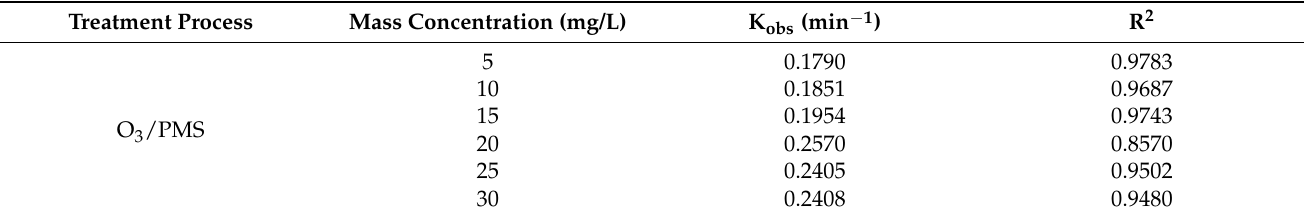
Table 5. Pseudo-first-order rate constants of O 3 /PMS under different PMS dosing concentrations (reaction conditions: SDZ = 10 mg/L, O 3 = 3 mg/L, T = 25 ± 0.5 ◦ C, pH = 6.8 ± 0.1, PMS = 5.7, 11.4, 17.1, 22.8, 28.5, 34.2